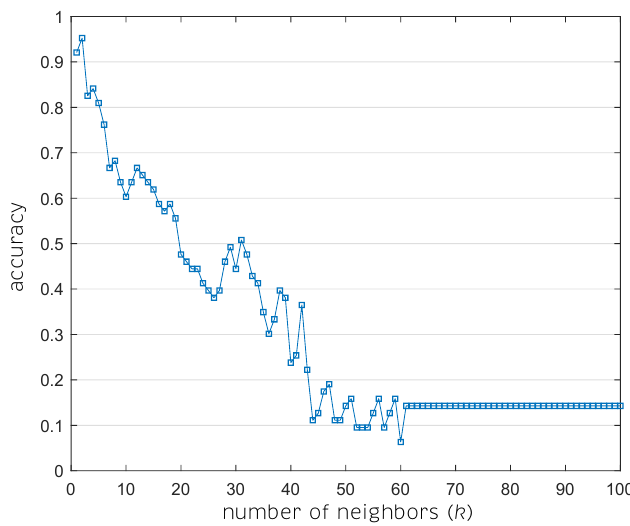
Figure 5. Accuracy behavior due to the variation of neighbors number in k NN classifier algorithm.